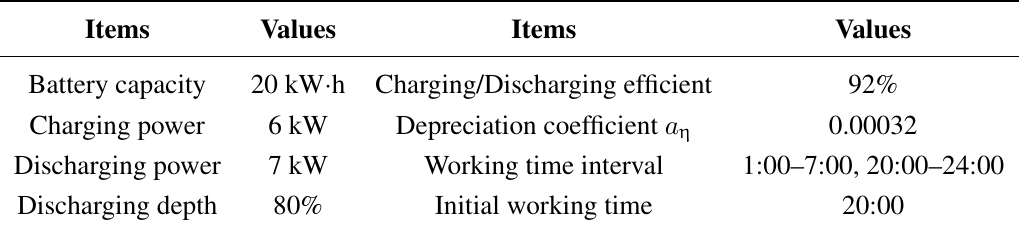
Table 3. Parameters for battery of household plug-in electric vehicle: battery is assumed to be charged right at the initial time for the case without energy consumption scheduling function deployment; for the case with energy consumption scheduling function deployment, the timing for charging of each plug-in electric vehicle is determined by the game result; the discharging power level, discharging time interval, and depreciation coefficient is only valid with energy consumption scheduling and discharging